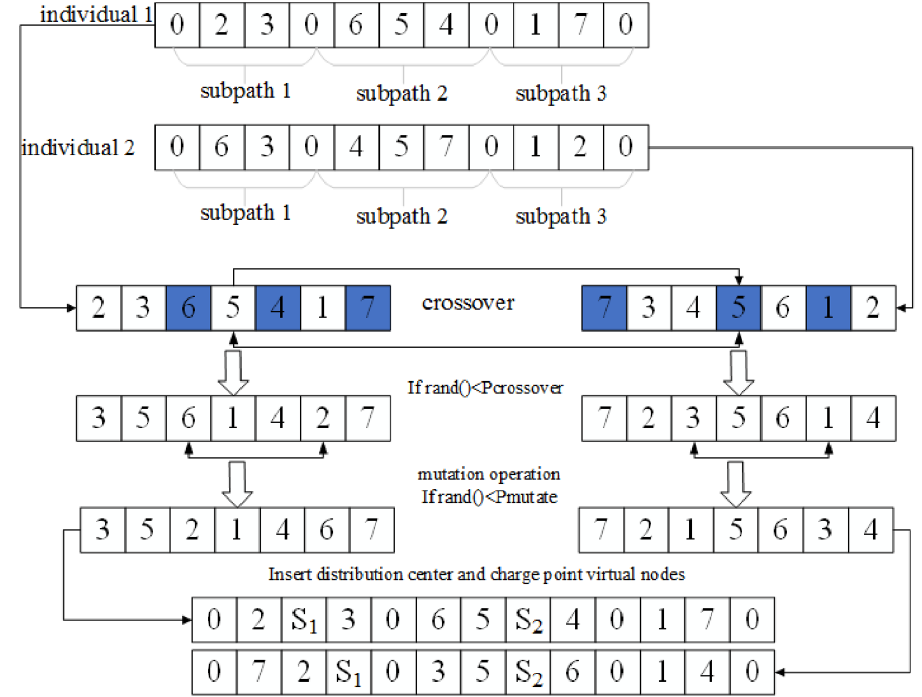
Fig 2. Path individual genetic operation with charging point